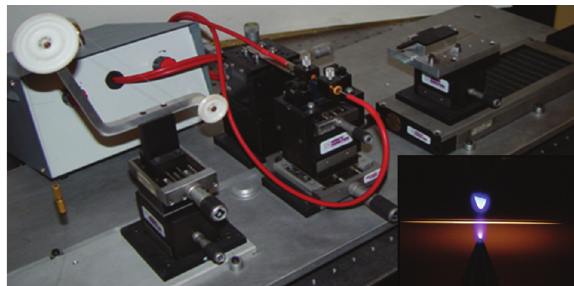
Figure 2: Setup for the fabrication of arc-induced